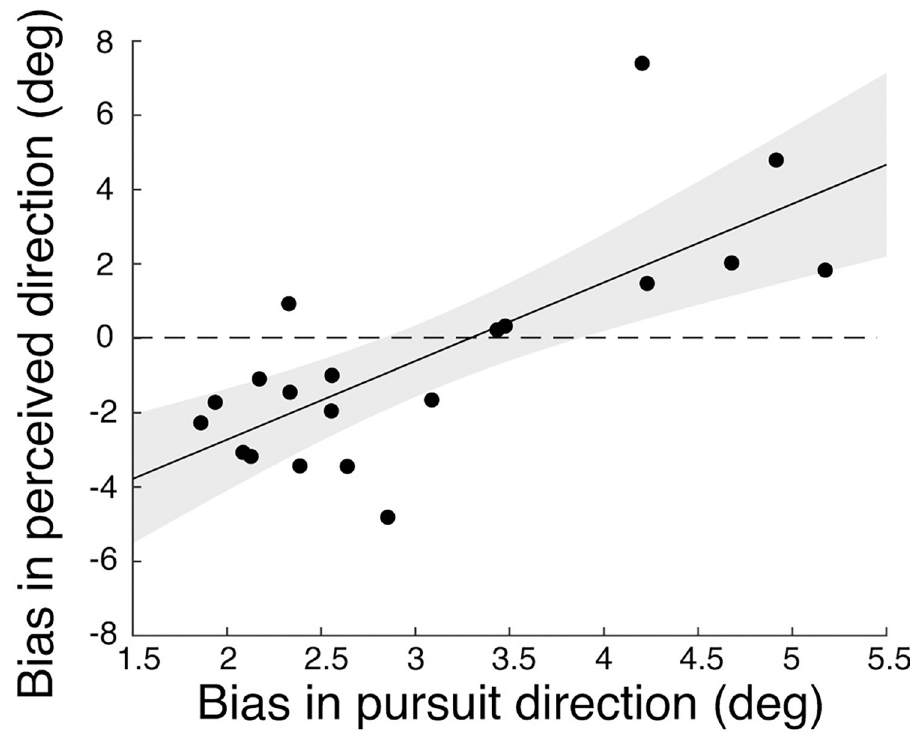
Fig 7. Correlation between the bias in perceived direction and the bias in pursuit direction across observers ( n = 20). Each data point indicates the average value between internal motion conditions for one observer (positive values indicated bias in the direction of internal motion). The solid line shows the least squares fit. The shaded area indicates the 95% CI. The dashed line indicates zero perceptual bias.